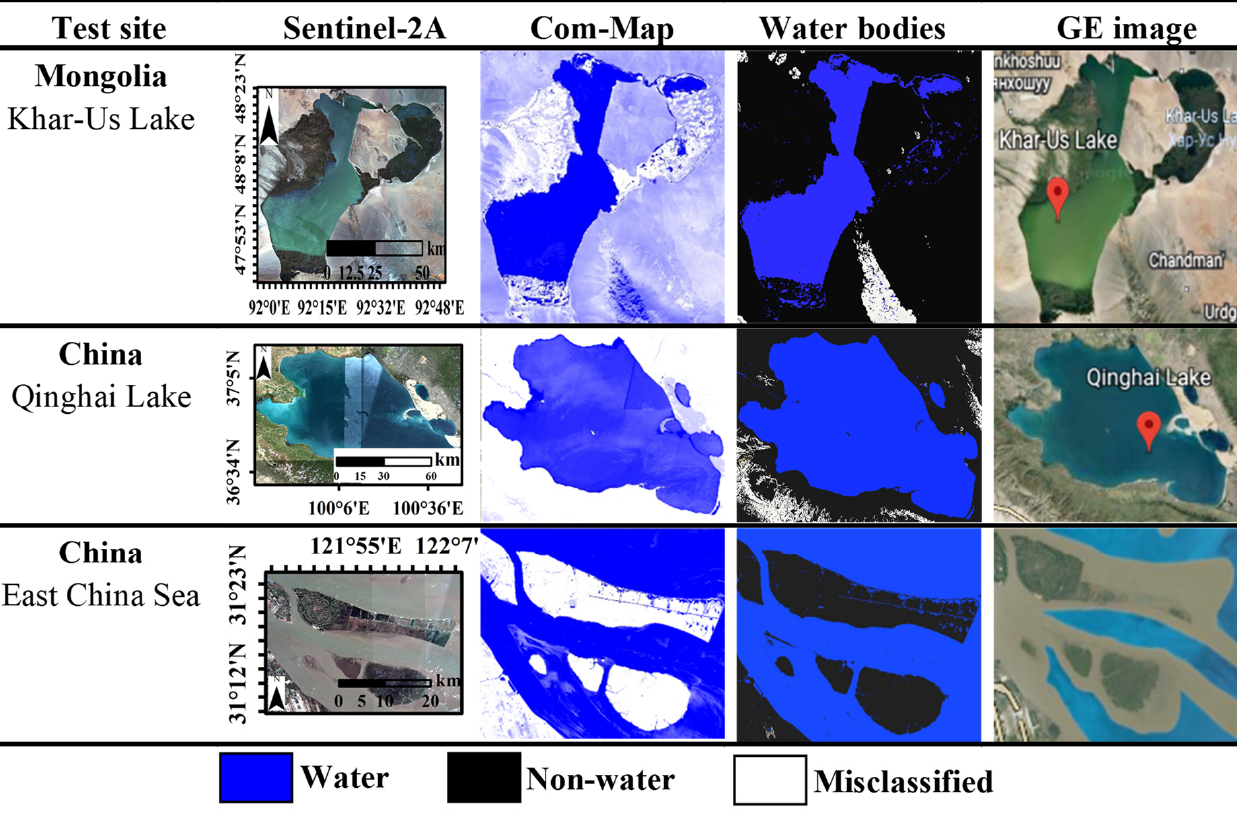
Figure 5. The results of water extraction using the TWI at three selected test sites. Sentinel-2 color composite bands 4, 3, 2 coded RGB. Google Earth Imagery: courtesy of Earth View.